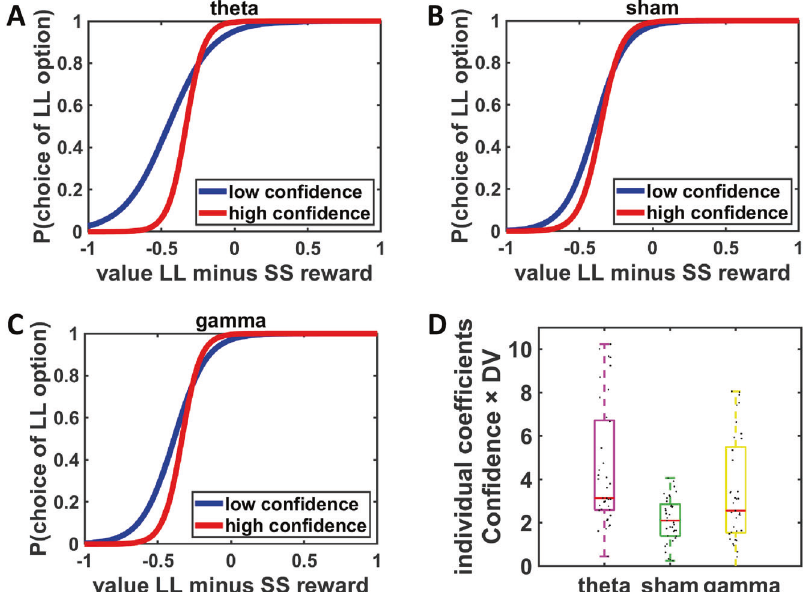
Fig. 2 Stimulation effects on metacognition based on the results of the mixed generalized linear model for the con fi dence accuracy task. A Theta tACS signi fi cantly improved metacognitive sensitivity in the con fi dence accuracy task compared with B sham and C gamma tACS, indicated by a larger difference between the slopes of logistic curves (these slopes capture revealed decision uncertainty) from low and high con fi dence decisions. For illustration, we split data into low and high con fi dence decisions. D Individual regression coef fi cients for the Difference in value (DV) × Con fi dence interaction, separately for theta, sham, and gamma tACS. DV is de fi ned as the difference between the subjective values of larger-later (LL) and smaller-sooner (SS) rewards. More positive coef fi cients indicate higher metacognitive accuracy. Colored boxes indicate median and interquartile range, whiskers are de fi ned as 1.5 times the interquartile range or up to the most extreme observed data point falling within this range. Black dots indicate individual data points ( N = 37 participants).